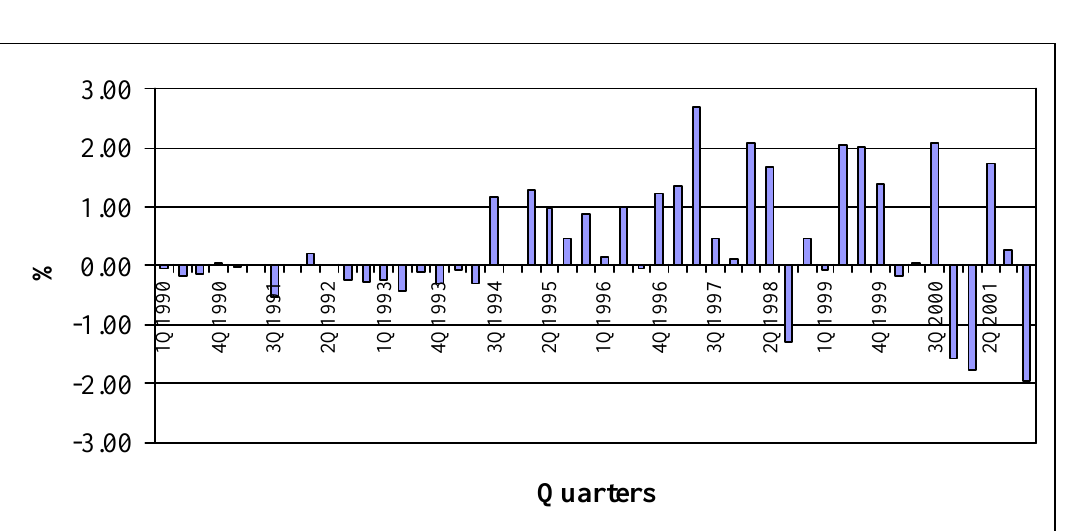
Figure 2 Total investment to